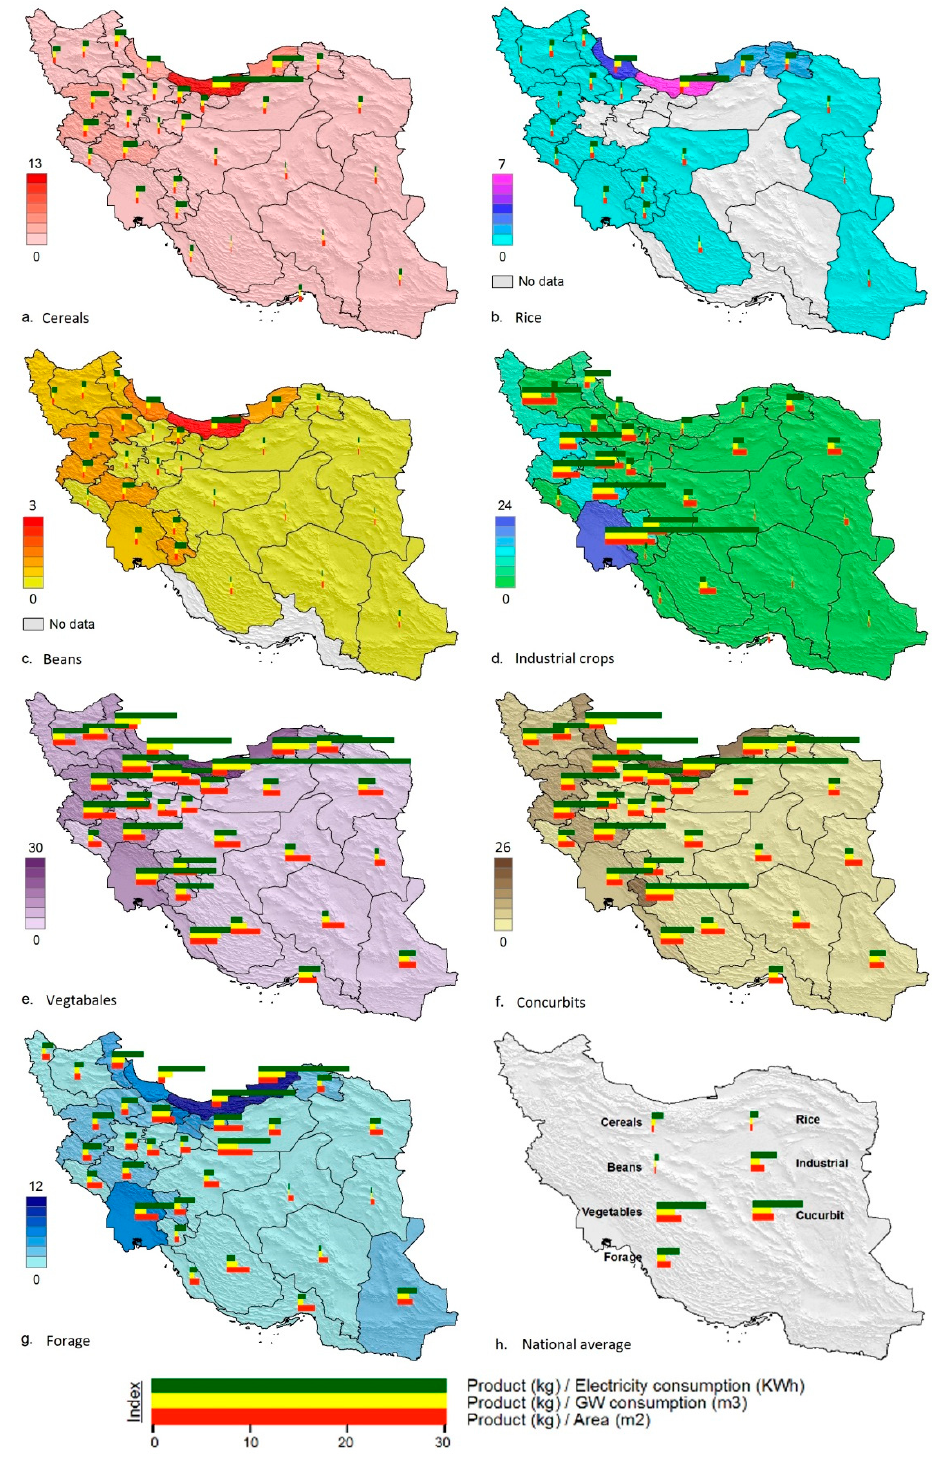
Figure 11. Provincial ( a – g ) and national ( h ) agronomic crop productivity based on GEF productivity indicators. Darker shades illustrate higher energy productivity (kg/Kwh) as a surrogate for GEF-nexus-based agronomic productivity.